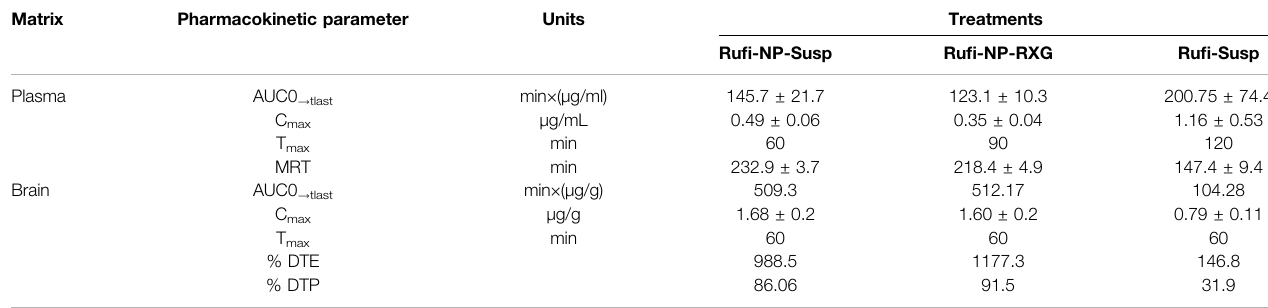
TABLE 3 | Pharmacokinetic parameters of Ru fi -NP-RXG, Ru fi -NP-Susp, and Ru fi -Susp in brain and plasma following in. administration at a drug dose of 1 mg/kg.